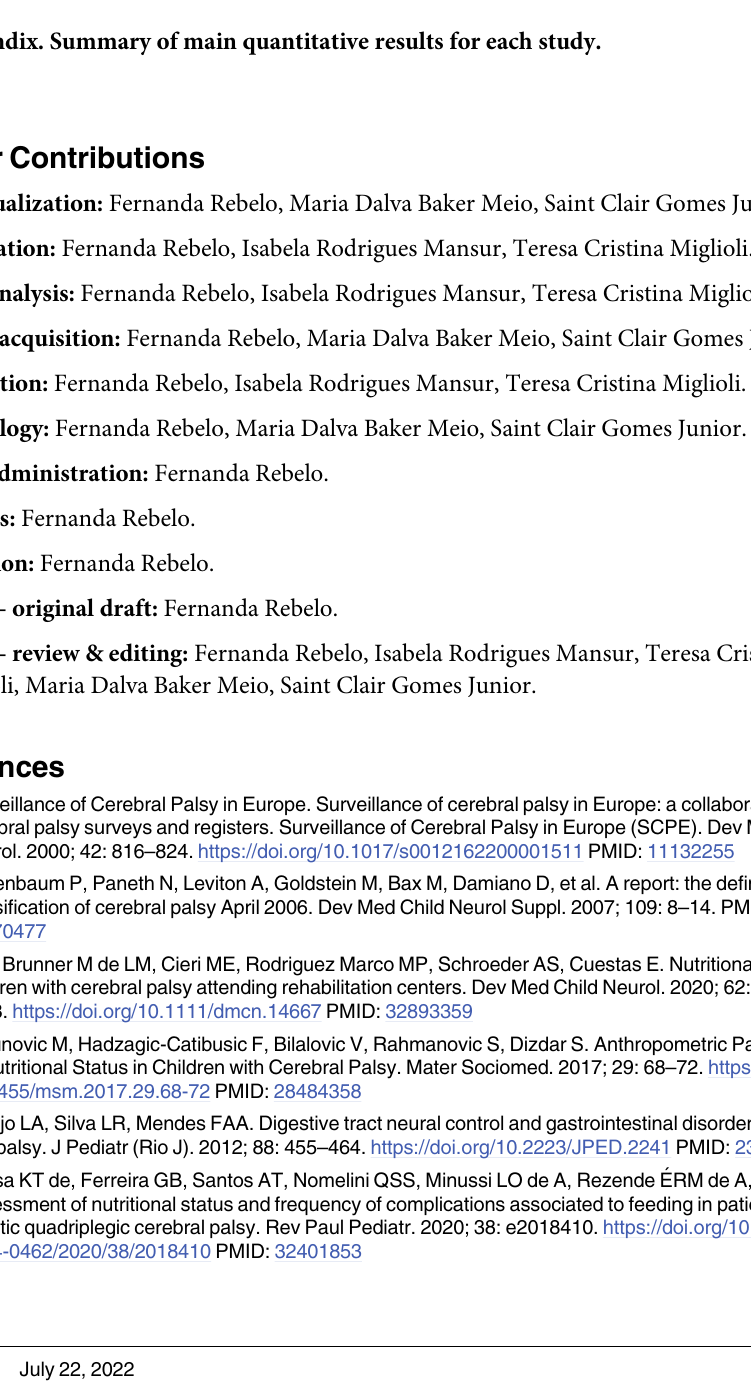
S2 Table. References excluded after full-text evaluation and respective